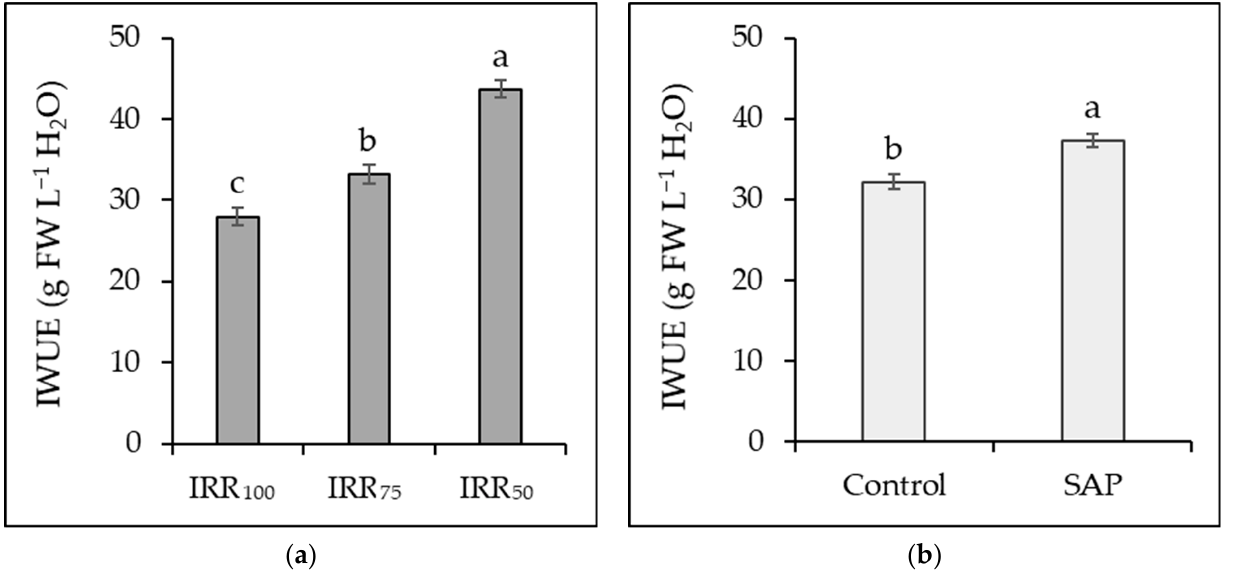
Figure 3. Single effect on irrigation water use efficiency (IWUE) determined by ( a ) irrigation treatments (100%, 75%, and 50% of ETc restoration, respectively IRR 100 , IRR 75 , and IRR 50 ) and ( b ) superabsorbent polymer applied to the soil (SAP-treated and non-treated control). Different letters indicate differences at p < 0.05. Vertical bars represent standard errors.